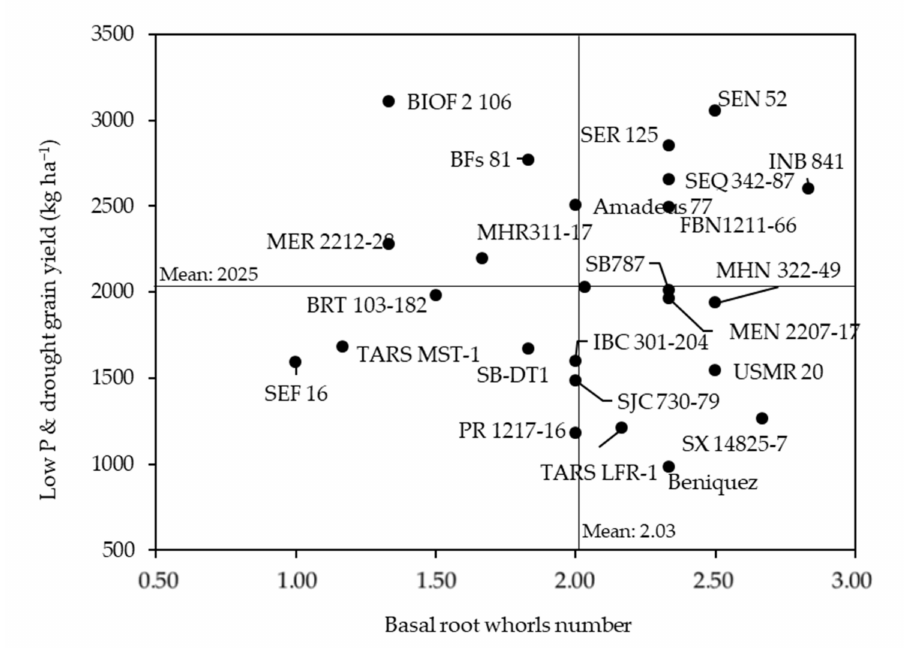
Figure 5. Genotypes with higher yield and superior basal root whorls number grown under low P and drought treatment. The outstanding genotypes with superior yield and basal root whorls number are in the upper right